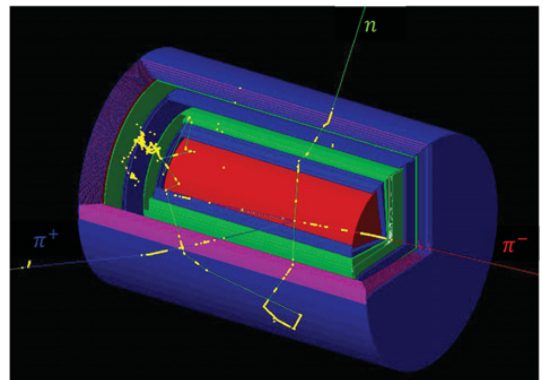
Figure 2. GEANT4 model of the detection system and an illustrative annihilation event that has is passed the criteria for event selection. Red cylinder: vacuum vessel, blue cylindrical layers: tracker layers of inner, middle and outer trackers, green: inner and outer hodoscope